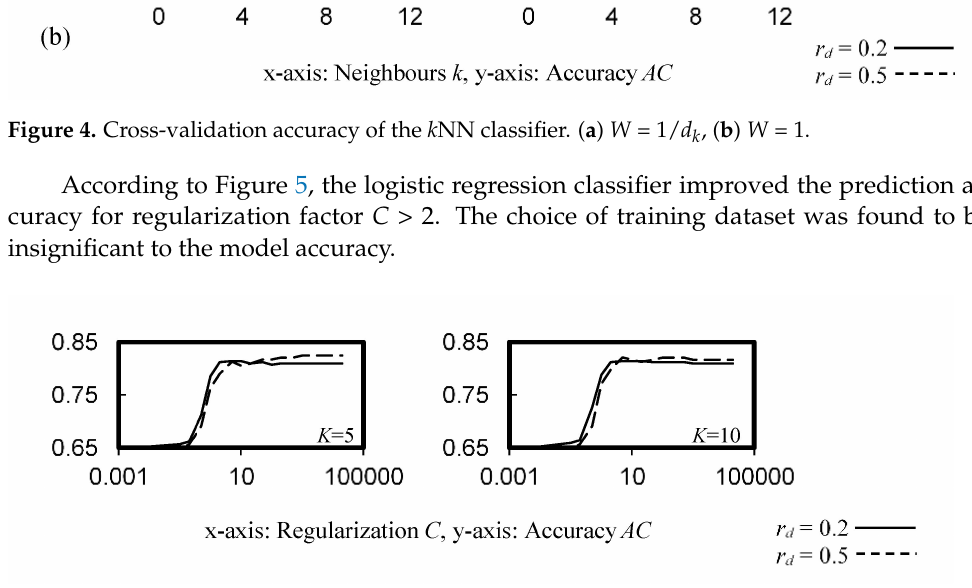
Figure 5. Cross-validation accuracy of the logistic classifier. Figure 6 graphs the cross-validation accuracy of the decision tree classifier.